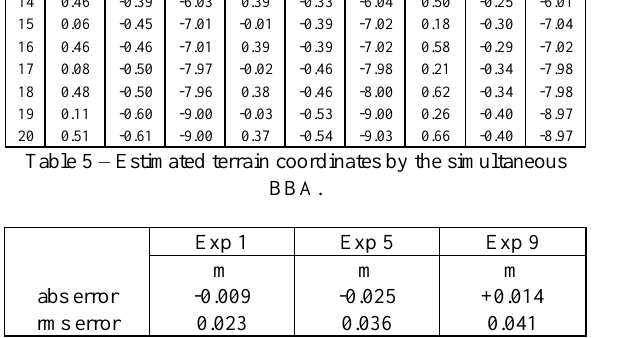
of the adjusted perspective centers corresponding the Exp 1.